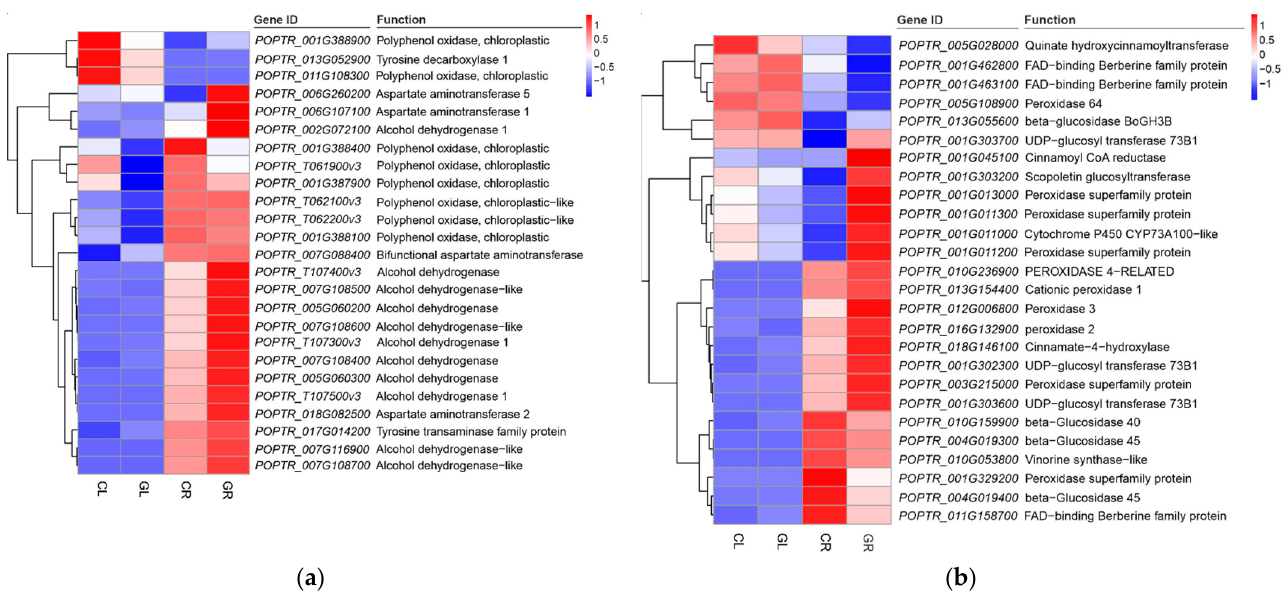
Figure 9. Expression pattern analysis of genes associated with tyrosine, phenylalanine and tryptophan metabolism ( a ) and phenylpropanoid biosynthesis pathway ( b ) by the pairwise comparisons of GL vs. CL and GR vs. CR. CL, CR, GL and GR represent the shoots and roots samples of the inorganic N control and the Gln treatment,